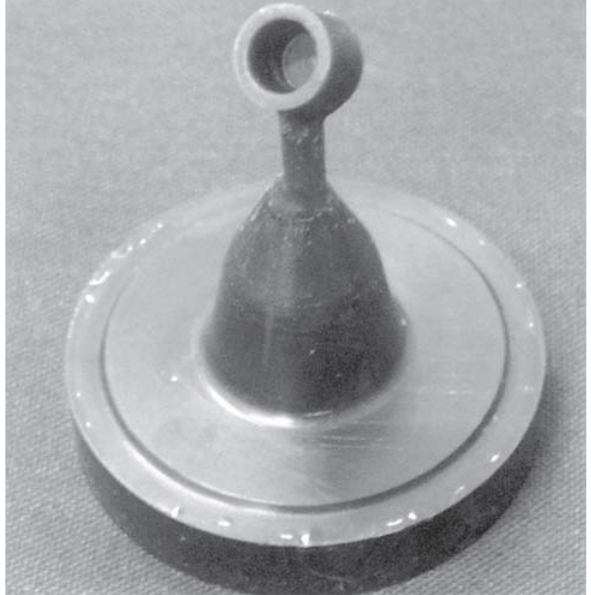
FIGURE 3- The sprued patterns mounted on crucible formers